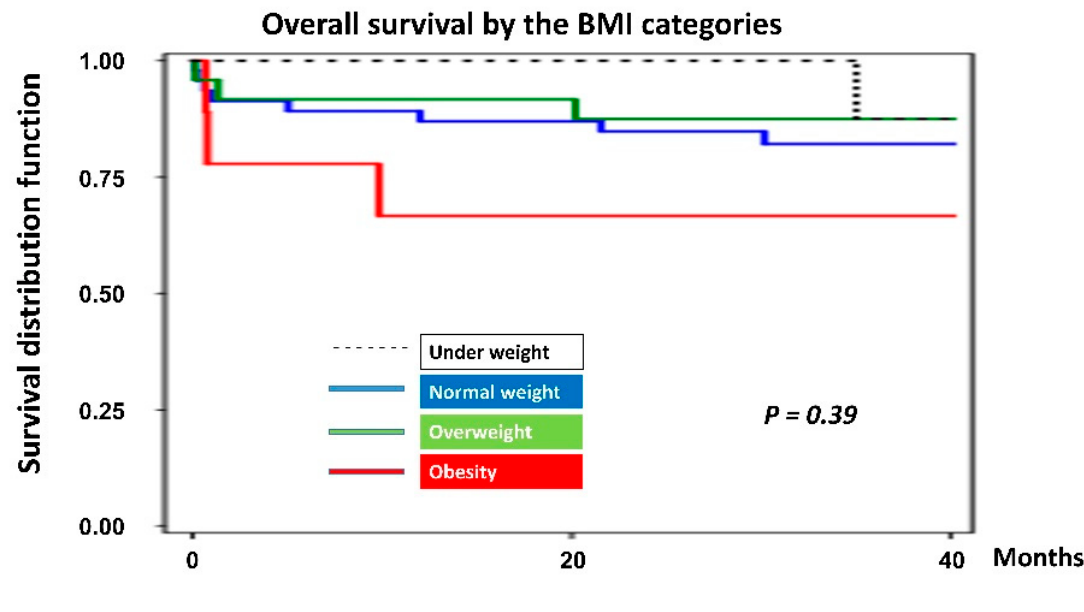
Figure 5. Kaplan–Meier graph of overall survival by body mass index categories.